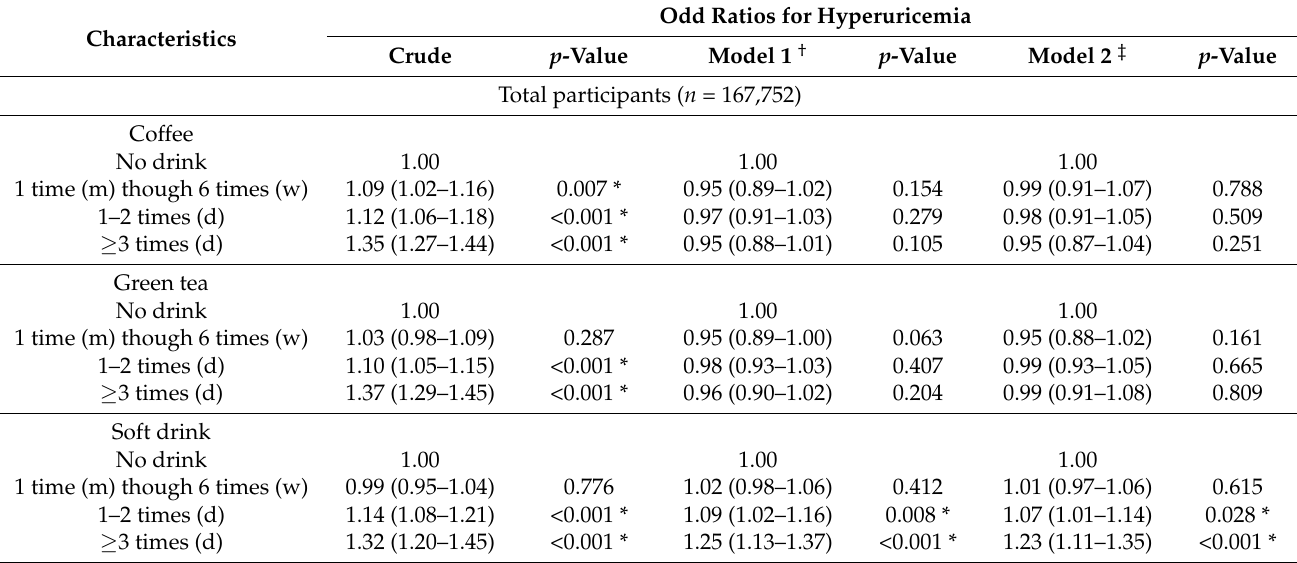
Table 2. Crude and adjusted odd ratios (95% confidence interval) of coffee, green tea, and soft drink intake (frequency) for